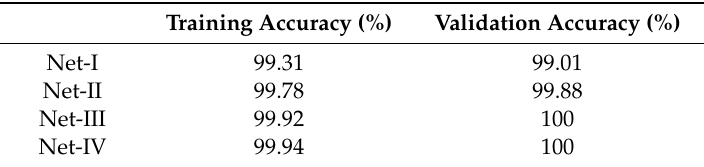
Table 11. Training and validation accuracies of four CNN